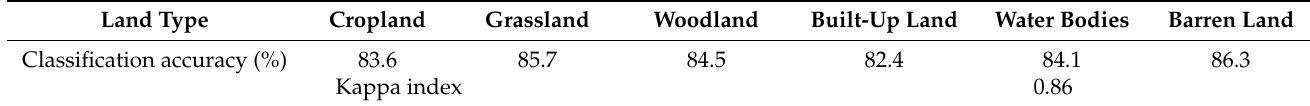
Table 1. Image classification accuracy.